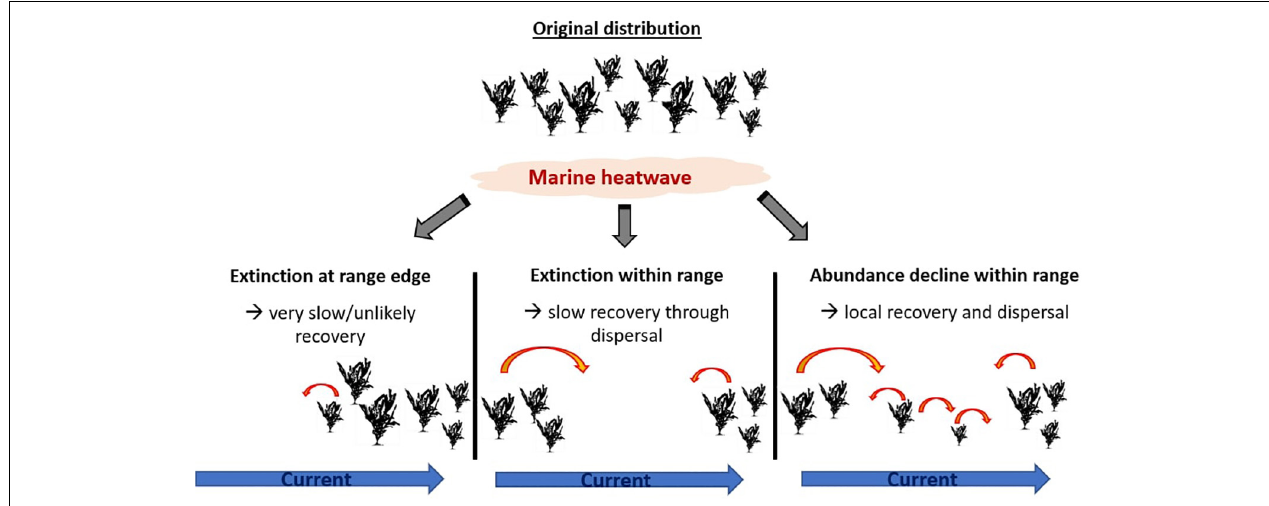
FIGURE 3 | Simplified single-species schematic of recovery possibility after a marine heatwave which resulted in local extinction at equatorward range edge, local extinction within distributional range and abundance decrease within distributional range. Red errors stand for dispersal, with decreased dispersal likelihood for smaller